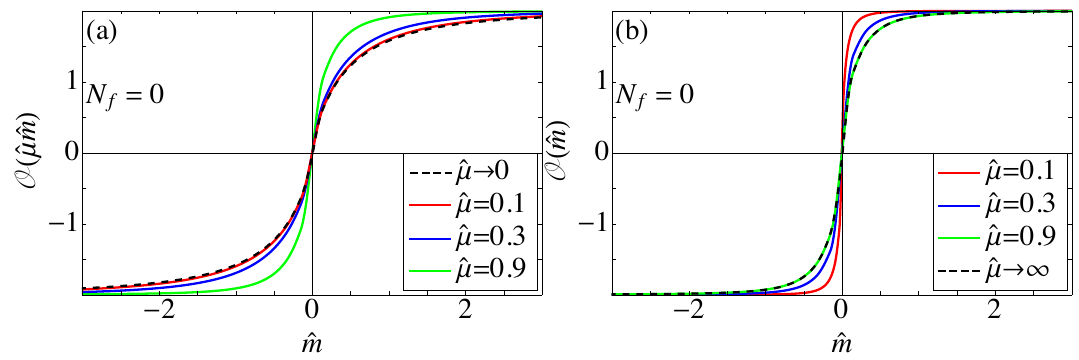
Figure 3 . Illustrated is the convergence of the analytical result (5.4) (solid coloured curves) to the limits (dashed black curves) (cid:22) ! 0 (left plot) and (cid:22) ! 1 (right plot). The analytic form of b b the limits is given in eqs. (5.6) and (5.5), respectively. We underline that in plot (a) we rescaled the mass by (cid:22) so that only the vicinity of the origin is shown. The asymptotics 2sign( b mass m lies at the top and bottom of the b